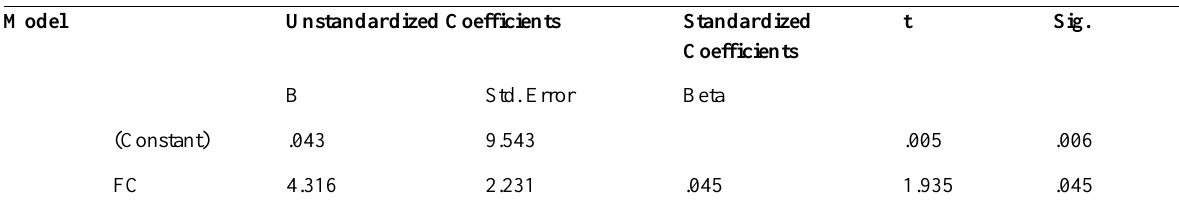
Table 4: Regression